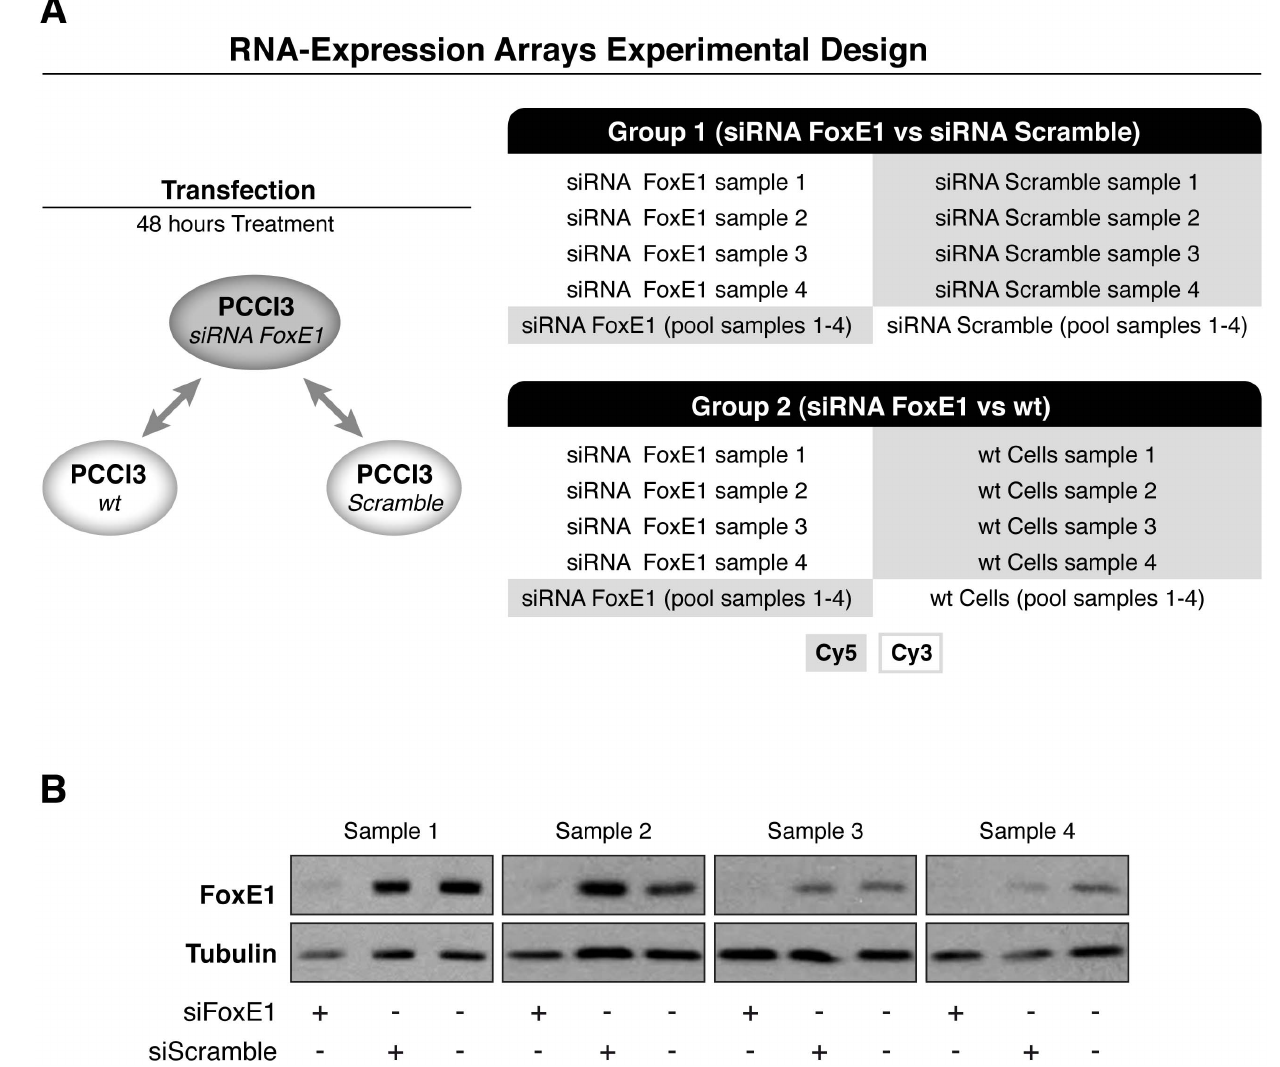
Figure 1. Experimental design and FoxE1 protein levels after 48 hours of silencing. Panel A: Experimental design of expression array experiments. Two comparisons were done: FoxE1-silenced PCCl3 cells (siFoxE1 PCCl3) vs. scrambled siRNA-treated PCCl3 cells (siScramble PCCl3), and FoxE1-silenced PCCl3 cells vs. wild type PCCL3 cells (wt PCCl3). Each comparison was performed in quadruplicate and using dye swaps. Panel B: Western Blot of extracts from control, siScramble and siFoxE1-treated cells from quadruplicate samples used for microarray analysis. Hybridizations were done with anti-FoxE1 antibodies; anti-tubulin antibodies were used as loading controls.